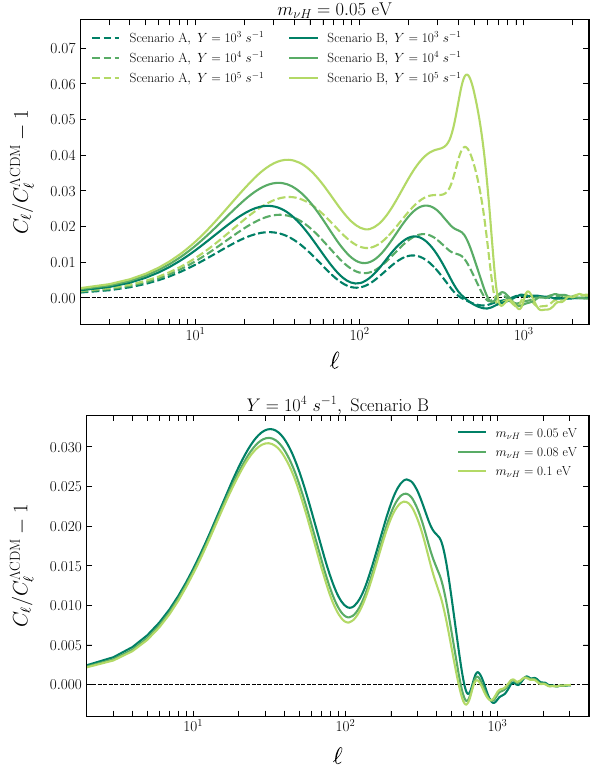
Table 1 All decay and free-streaming (FS) scenarios considered in this work, and their corresponding mass ordering (NO or IO), decay mass gap, and minimum allowed parent neutrino mass m ν H . We use the convention m 3 > m 2 > m 1 for normal mass ordering and m 2 > m 1 > m 3 for inverted mass ordering, and a common value Δ m 2